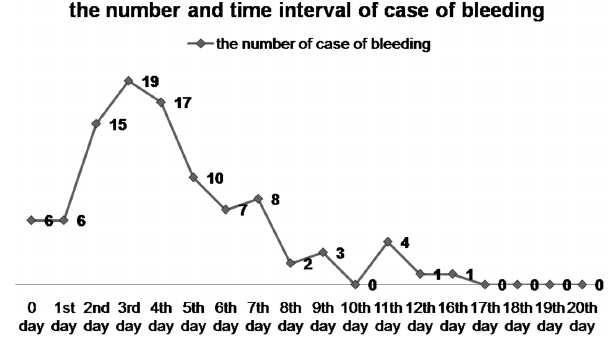
Figure 1. The number of cases of delayed bleeding, and time interval between the time of polypectomy and the occurrence of delayed hemorrhage. 0 day, 1st day, 2nd day, et al represent the time intervals.